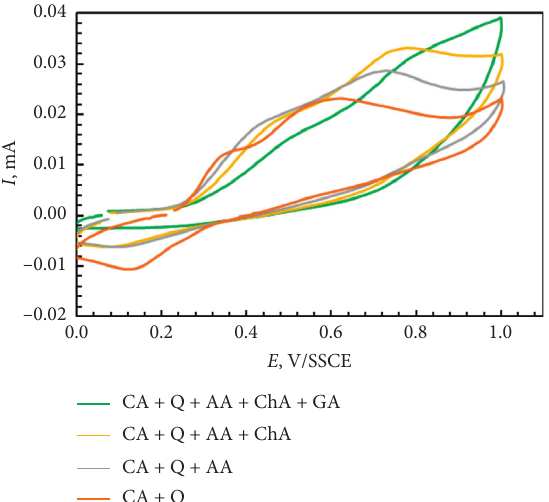
Figure 11: Cyclic voltammograms of a mixture of phenolic acids and monoterpenoid phenols at 0.5mM/L concentration in acetate buffer 0.1M (pH 4) and NaClO 4 (70: 28: 2). CA, caffeic acid; Q, quercetin; AA, ascorbic acid; ChA, chlorogenic acid; GA, gallic acid. Scan rate – 100mVs − 1 . Table 8: Redox potentials of individual compounds determined with cyclic voltammetry (CV).